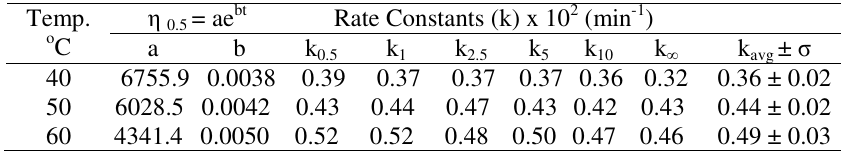
Table 1. Empirical constants and reaction rate constants of the propellant slurry at different rpm(s).